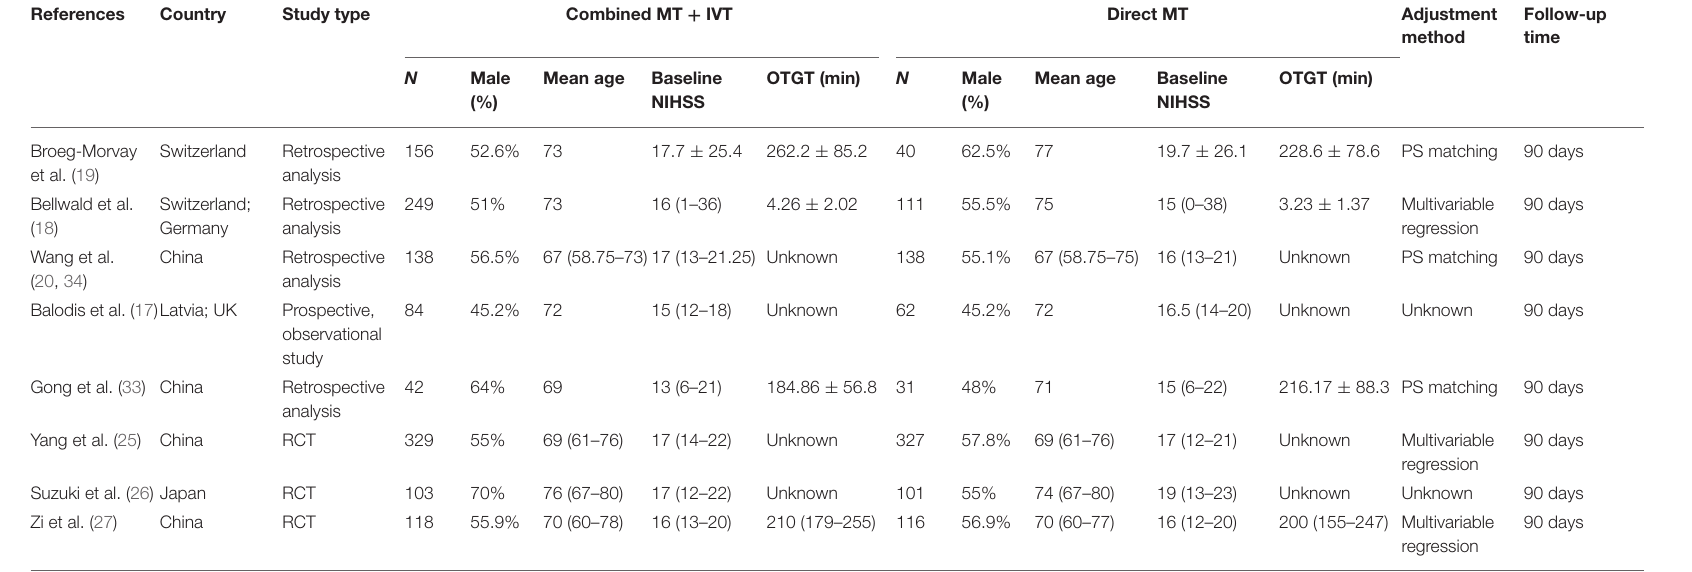
PS matching, propensity score